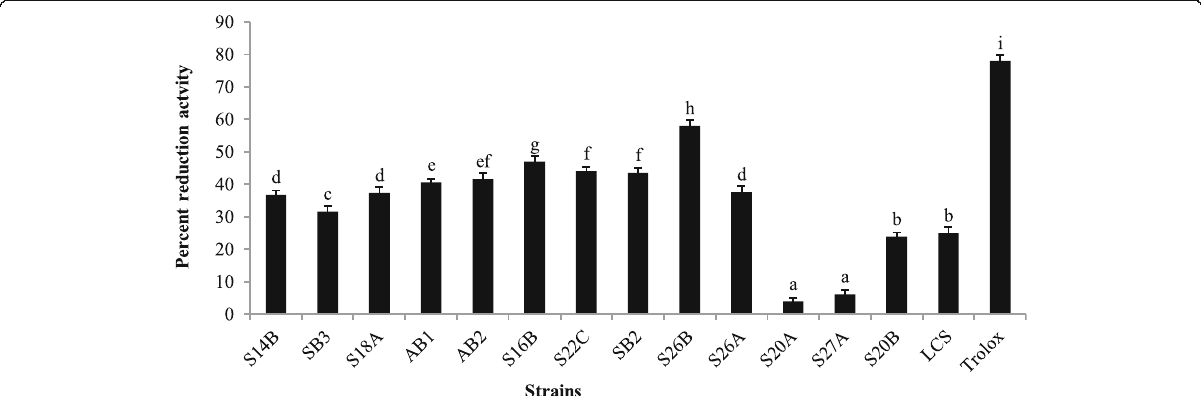
Fig. 5 Antioxidant activity of Enterococcus cell-free supernatant by DPPH free radical scavenging assay. Columns with different letters are significantly different p < 0.05